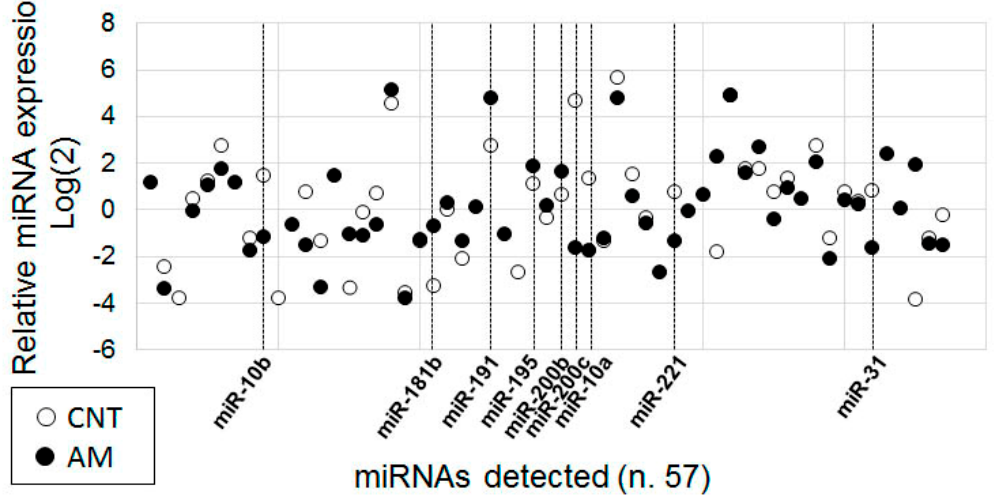
Figure 2. The miRNA expression profile of the eutopic endometrium of healthy women (CNT) and women with adenomyosis (AM). The results of the RT-PCR analysis of the pooled samples: 10 RNA samples from the endometrium of healthy women (CNT) and 10 RNA samples from the ectopic endometrium of women with adenomyosis (AM). The PCR results were normalized to the global Ct mean (28.2) and log 2 transformed. The expression in either CNT or AM samples was detected for 57 miRNAs from the 170 tested. miRNAs with obvious expression differences between CNT and AM are indicated.